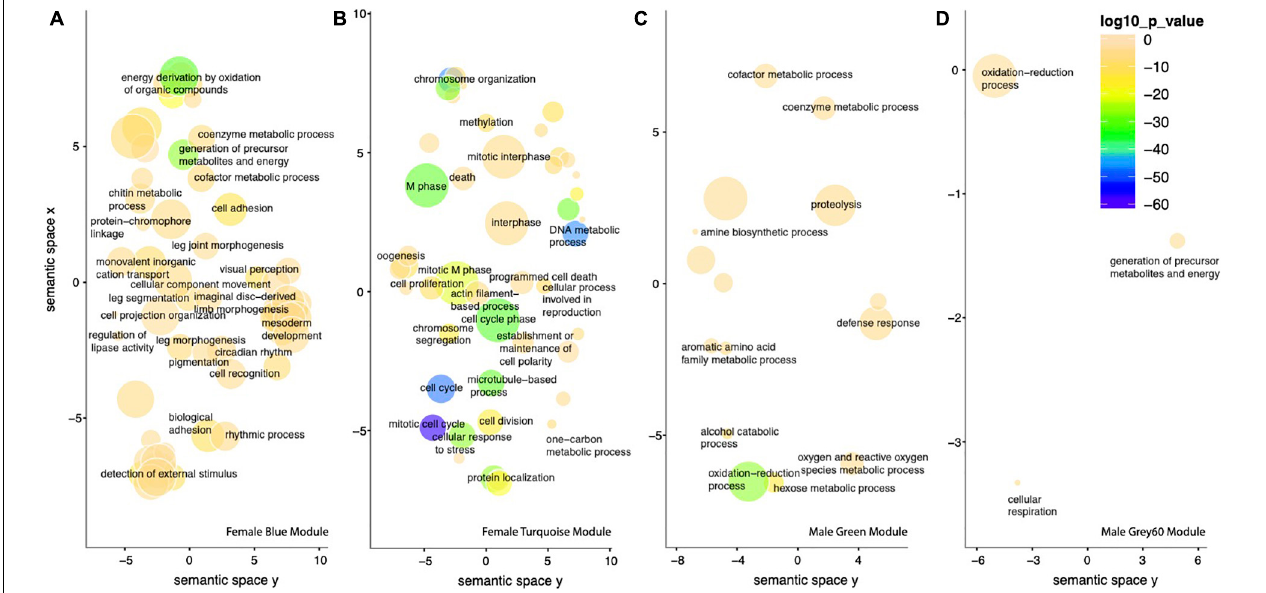
FIGURE 5 | Summarization of module GO annotation using REVIGO. Representative GO terms summarizing (A) the 373 GO terms significantly associated with the blue female module, (B) the 564 GO terms associated with the turquoise female module, (C) the 75 GO terms associated with the green male module, and (D) the 21 terms associated with the gray60 male module. Each scatterplot shows the cluster representatives (i.e., terms remaining after the redundancy reduction) in a two dimensional space derived by applying multidimensional scaling to a matrix of the GO terms’ semantic similarities. Bubble size indicates the frequency of the GO term in the underlying GO database; more general terms have larger bubbles. Bubble color indicates the significance of the enrichment in the DAVID analysis (log10 p